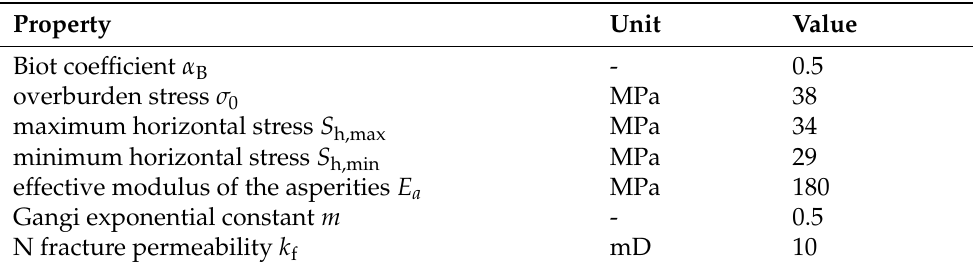
Table 6. Geomechanical parameters of Barnett shale for simulation AE2; the other input data are shown in Tables 2 and